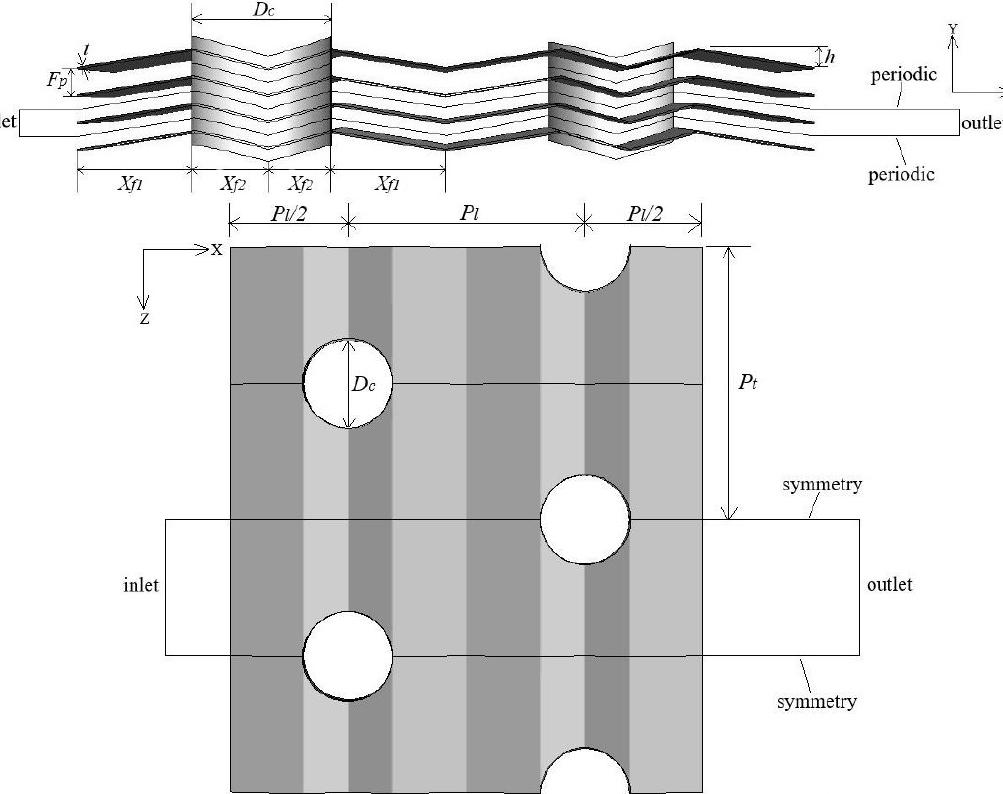
Figure 1. Physical model and geometrical parameters of simulated wavy fin.